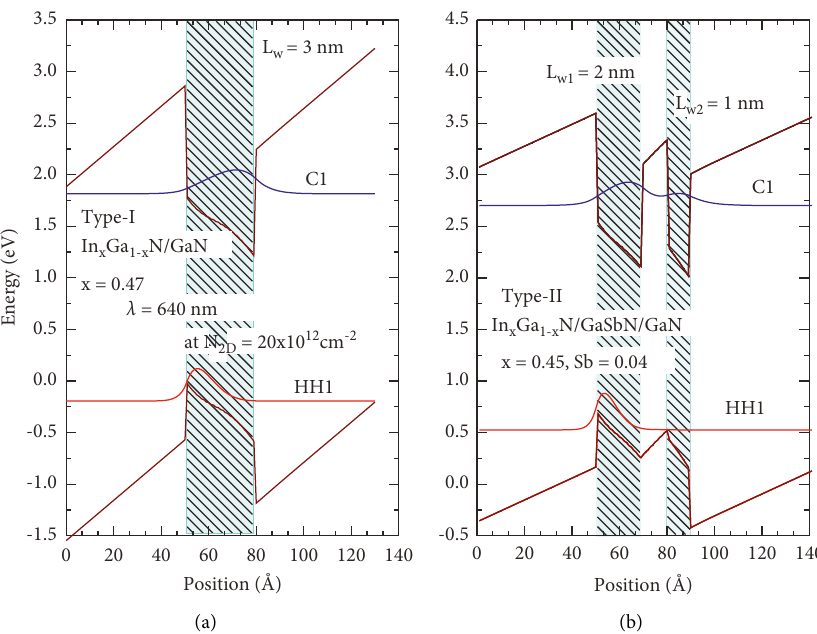
Figure 1: Potential energy profiles for (a) type-I In QW structures. The wavefunctions of the first conduction subband (C1) and the first valence subband (HH1) at the zone center are also shown as blue and red lines,